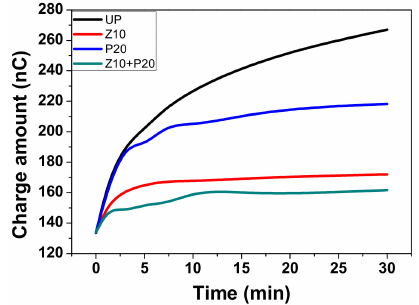
Figure 11. Absolute charge amount in the treated and untreated